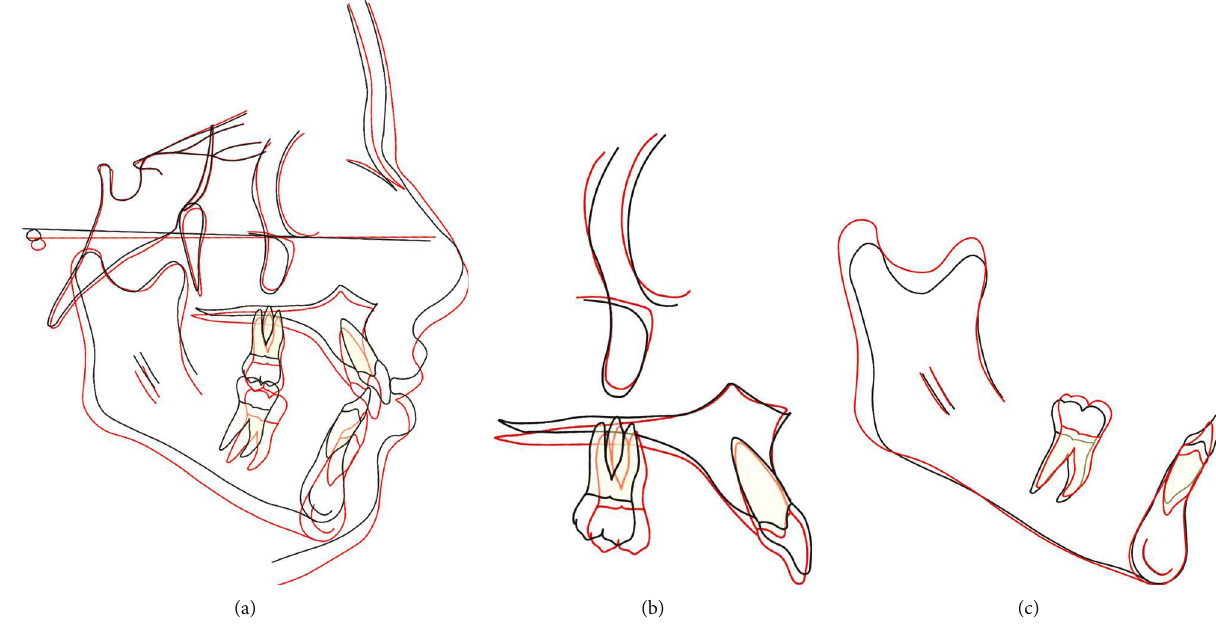
Figure 15: Cephalometric tracings before (black lines) and after treatment (red lines) were superimposed using Björk and Skieller ’ s structural method. (a) General superimposition of the cephalometric tracings before and after treatment on the anterior cranial base. (b) Superimposition of the maxillary tracings before and after treatment on the anterior contour of the zygomatic process. (c) Superimposition of the mandibular tracings before and after treatment on the stable structures in the